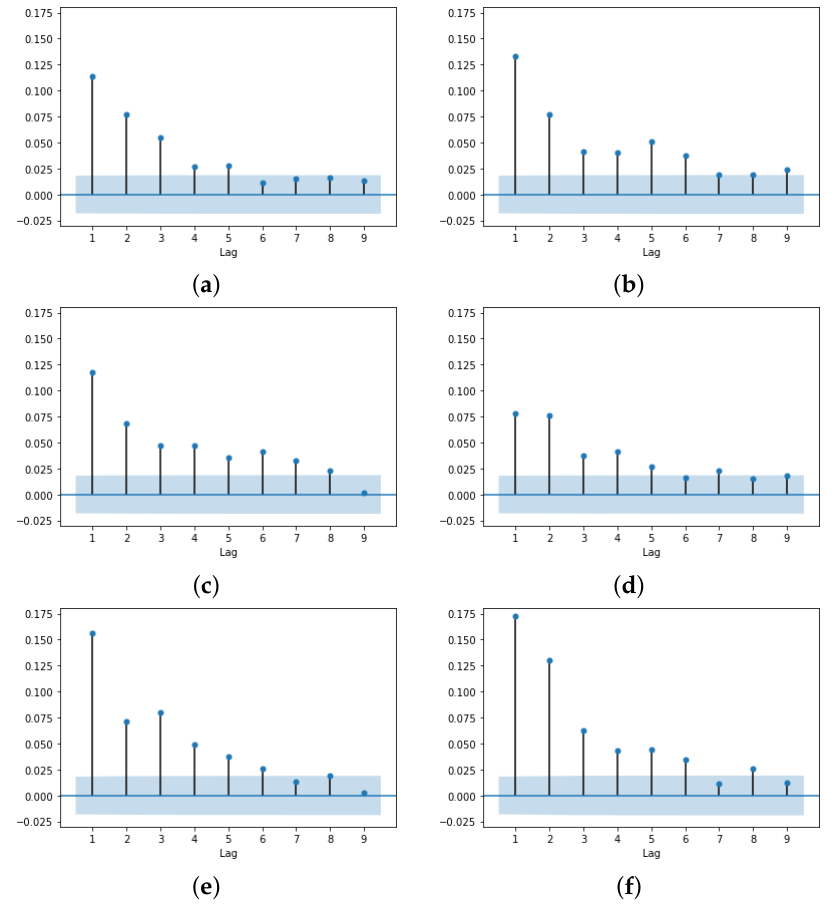
Figure 7. 2-s squared returns autocorrelation. ( a ) CDA. ( b ) FBA (0.5). ( c ) FBA (1.0). ( d ) HVCDA. ( e ) FBA (1.5). ( f ) FBA